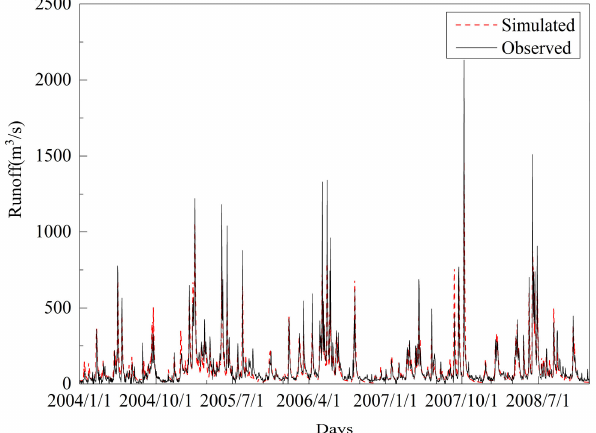
Figure 10. Comparison of daily observed and simulated runoff for solution R from multi-objective